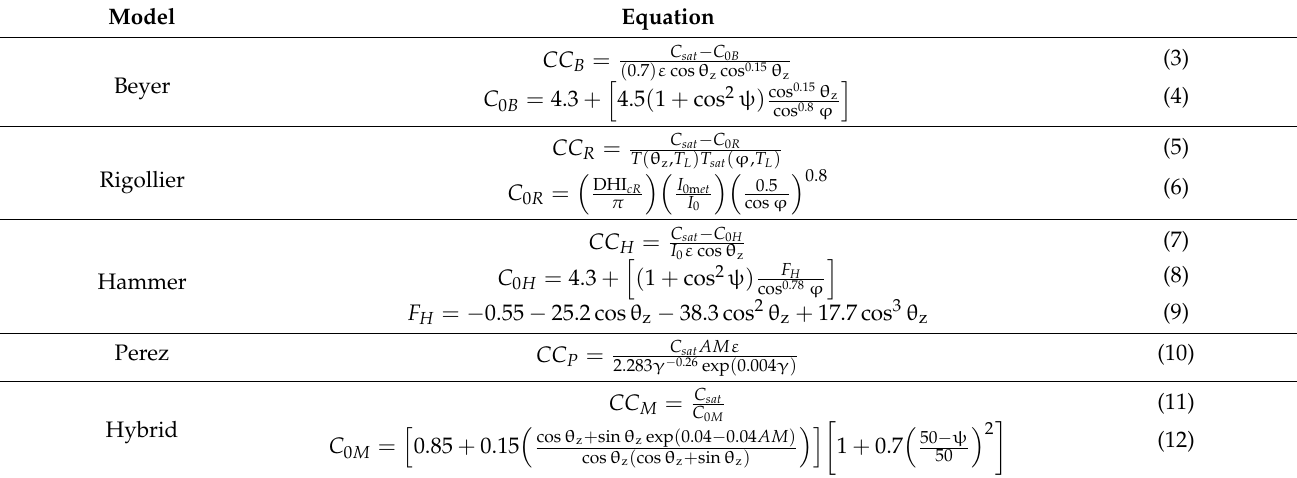
Table 2. Pixel normalization formulas for obtaining an independent cloud index (CI) (step 2). Each “raw” pixel ( C sat ) is subjected to this normalization before CI